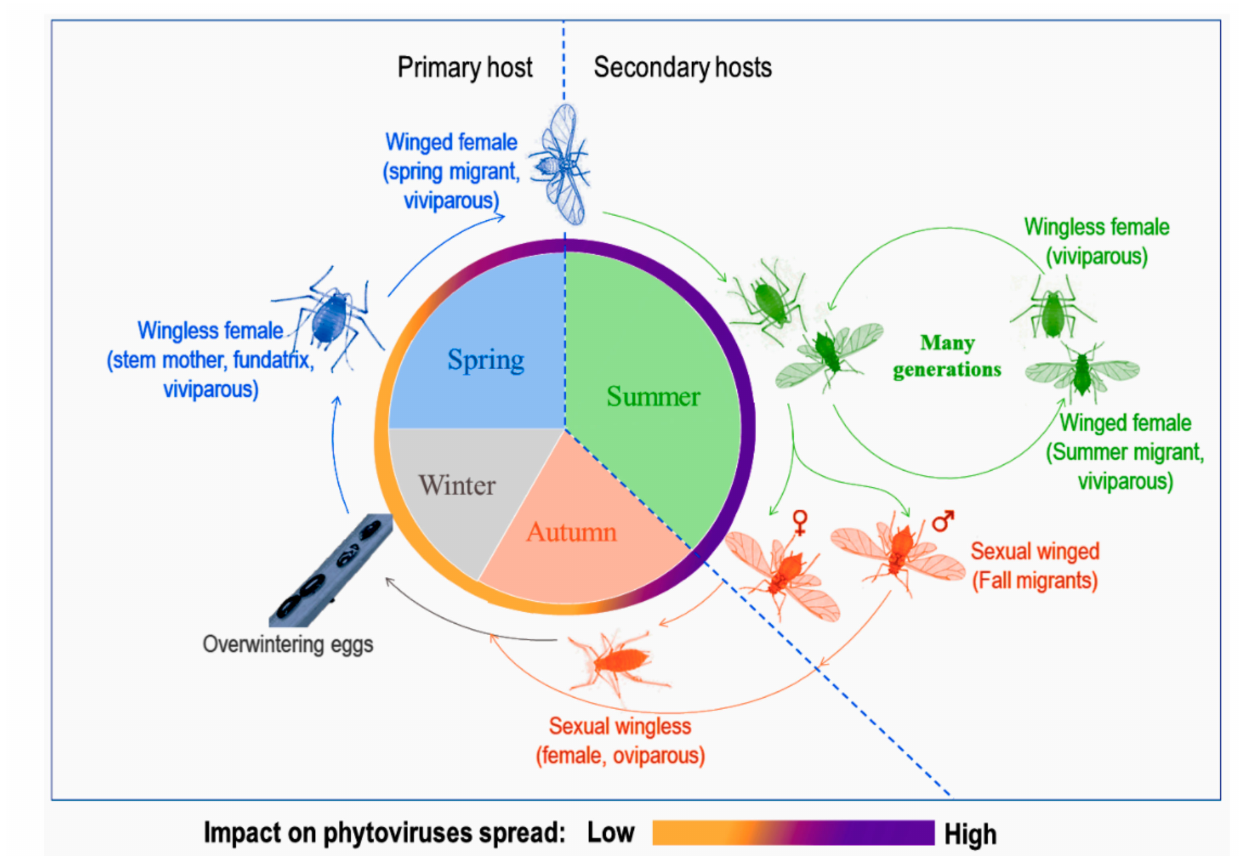
Figure 1. A representation of a dieocic aphid life cycle with at least two plant hosts and its impact on phytoviruses spread, adapted from